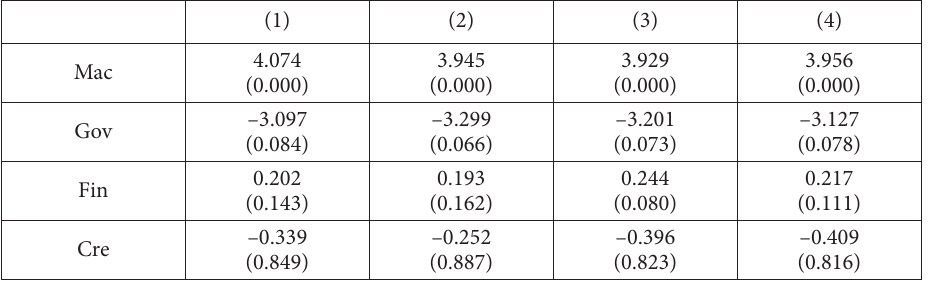
Table 9. Results of Model